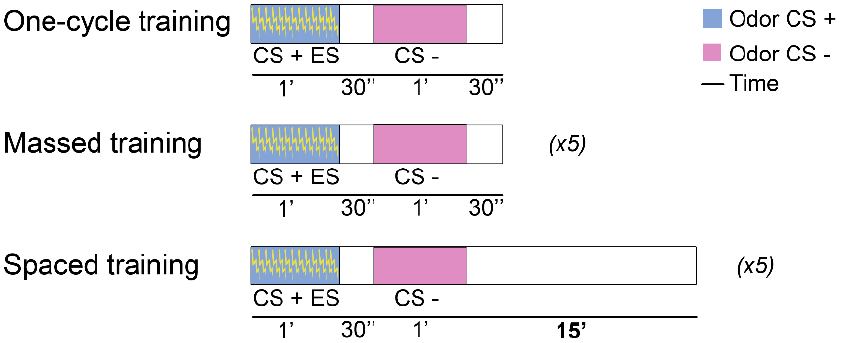
Figure 2. Standard training protocols for aversive olfactory association conditioning in Drosophila. The difference between the two multiple-cycle training protocols, massed and spaced, lies in the absence of a fifteen-minute resting interval.